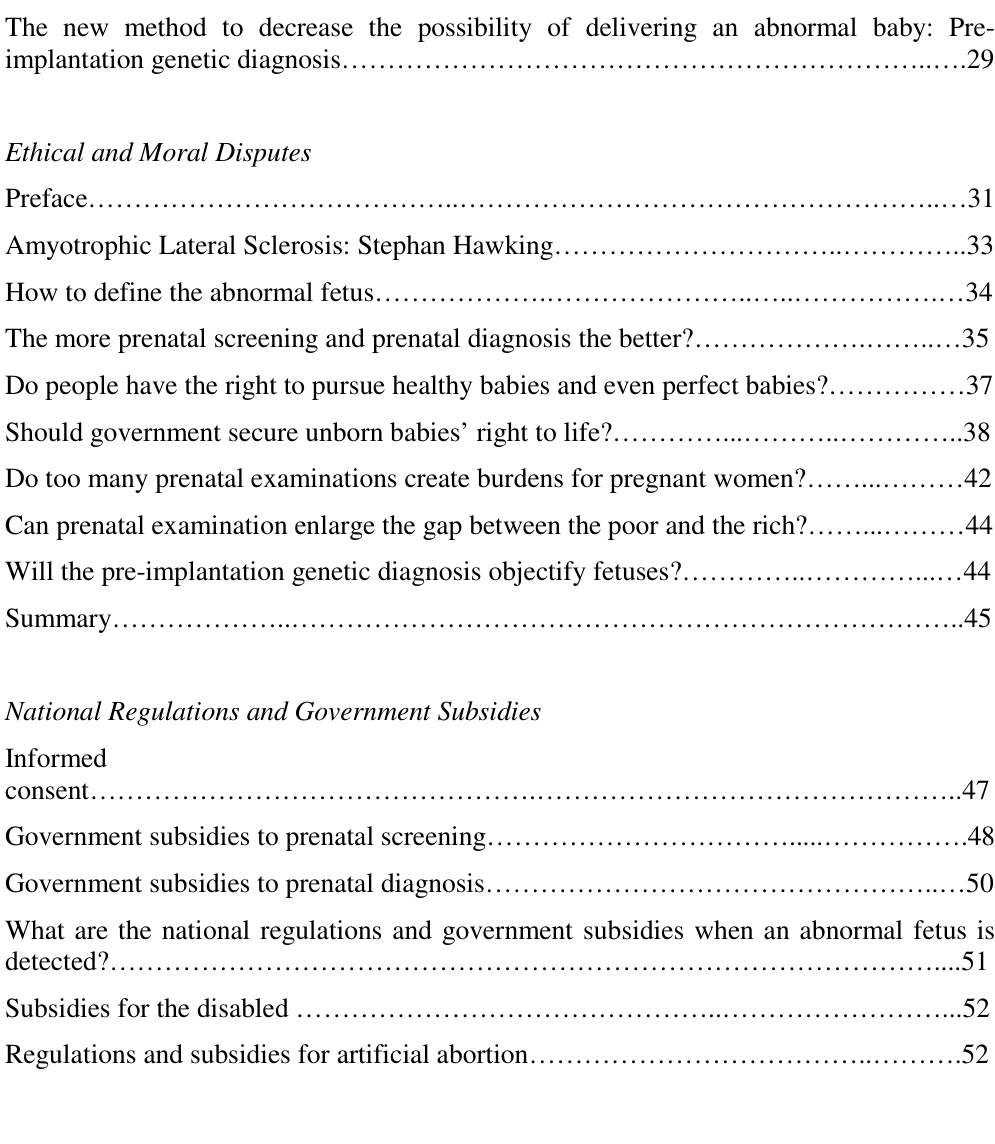
The new method to decrease the possibility of delivering an abnormal baby: Pre-